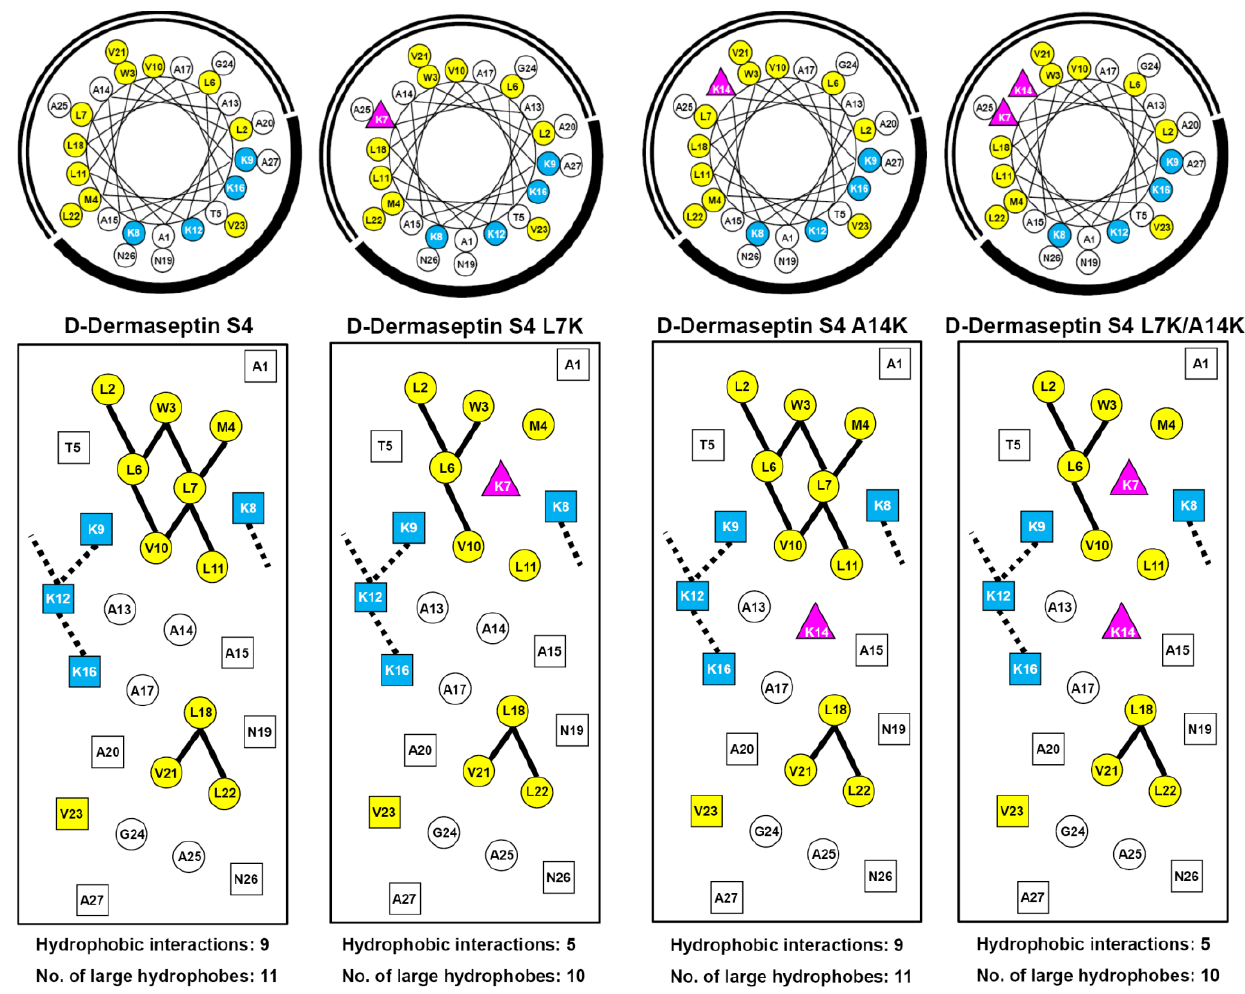
Figure 2. Helical wheel (upper panel) and helical net (lower panel) representation of D -dermaseptin S4 and analogs are shown in Table 1. The one-letter code is used for amino acid residues. D denotes that all residues in the peptides are in the D conformation. Positively charged residues (Lys) are colored blue, large hydrophobic residues (Val, Leu, Met and Trp) are colored yellow. The ―specificity determinants‖ are denoted by pink triangle(s). In the helical wheel, the non-polar face is indicated as an open arc and the polar face is shown as a solid arc. In the helical net, the residues on the polar face are boxed and the residues on the non-polar face are circled. The i → i +3 and i → i +4 potential hydrophobic interactions along the helix are shown as black bars. The i → i +3 and i → i +4 potential electrostatic repulsions between positively charged residues along the helix are shown as dotted